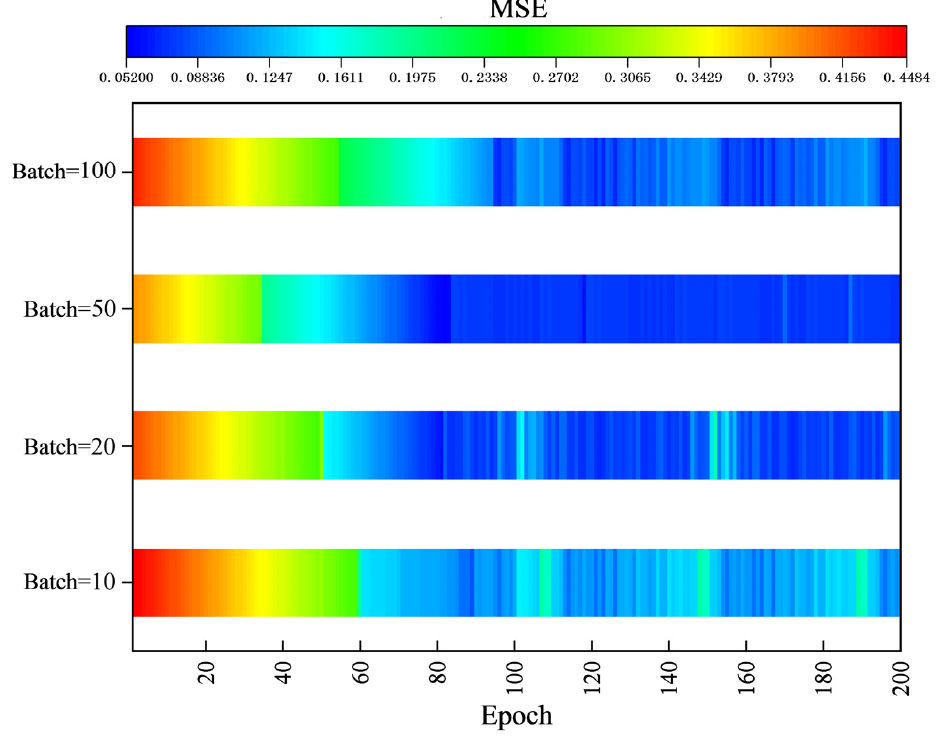
Figure 4. Comparison of batch size losses.